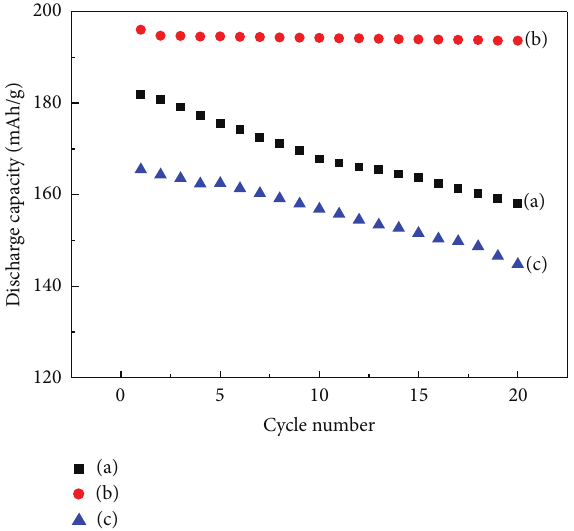
Figure 5: Discharge capacity versus cycle number for